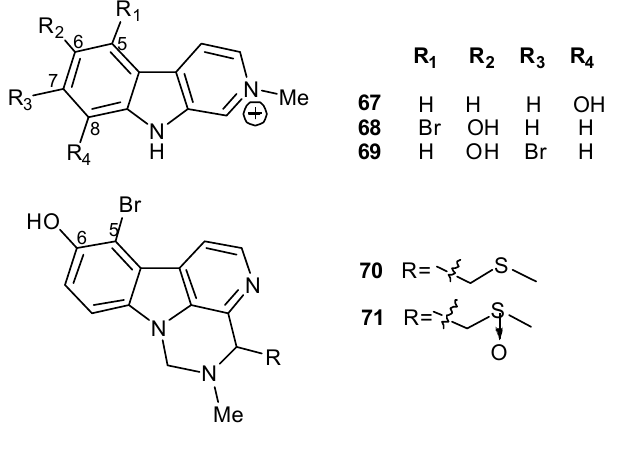
Figure 5. N -methyl  -carbolinium ( 67–69 ) and tetrahydropyrimidine ring containing ( 70 and 71 )  -carboline